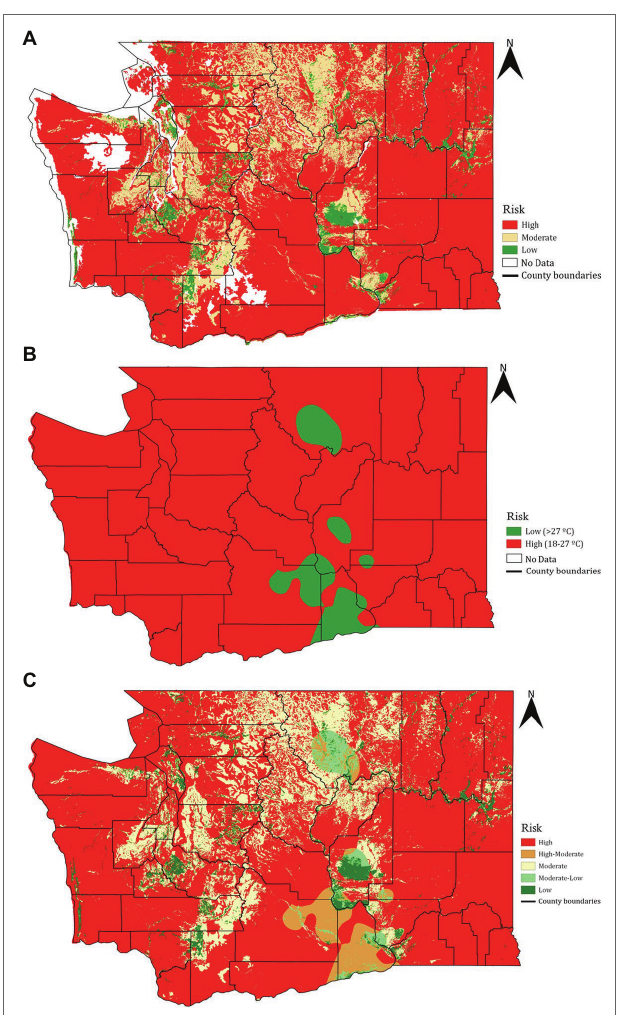
FIGURE 4 | Phylloxera risk maps derived from (A) soil sand content, (B) soil temperature, and (C) combined sand content and soil temperature data. Larger versions of these maps are available on https://wine.wsu. edu/extension/grapes-vineyards/grape-pests/phylloxera.